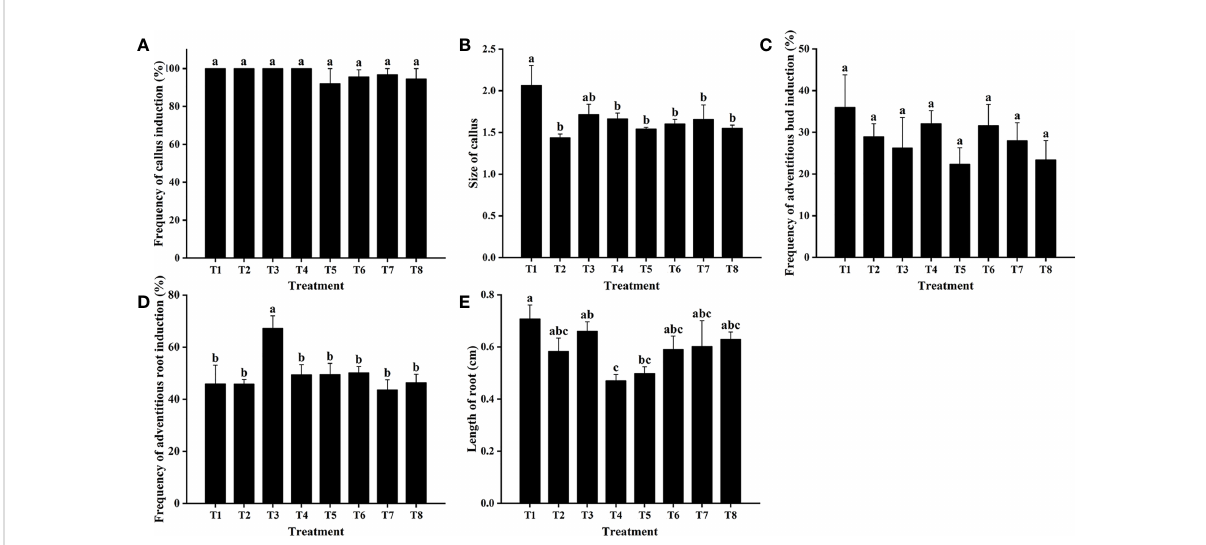
FIGURE 3 Effects of cefotaxime (Cef) and timentin (Tmt) on regeneration of E. urophylla × E. grandis DH32-29. Effects of Cef and Tmt on (A) the frequency of callus induction, (B) callus size, (C) frequency of adventitious bud induction, (D) frequency of adventitious root induction, and (E) length of roots. Combinations of antibiotics: T1: 0 mg·L − 1 Cef and 0 mg·L − 1 timentin (Tmt), T2: 100 mg·L − 1 Cef and 0 mg·L − 1 Tmt, T3: 200 mg·L − 1 Cef and 0 mg·L − 1 Tmt, T4: 300 mg·L − 1 Cef and 0 mg·L − 1 Tmt, T5: 400 mg·L − 1 Cef and 0 mg·L − 1 Tmt, T6: 100 mg·L − 1 Cef and 100 mg·L −